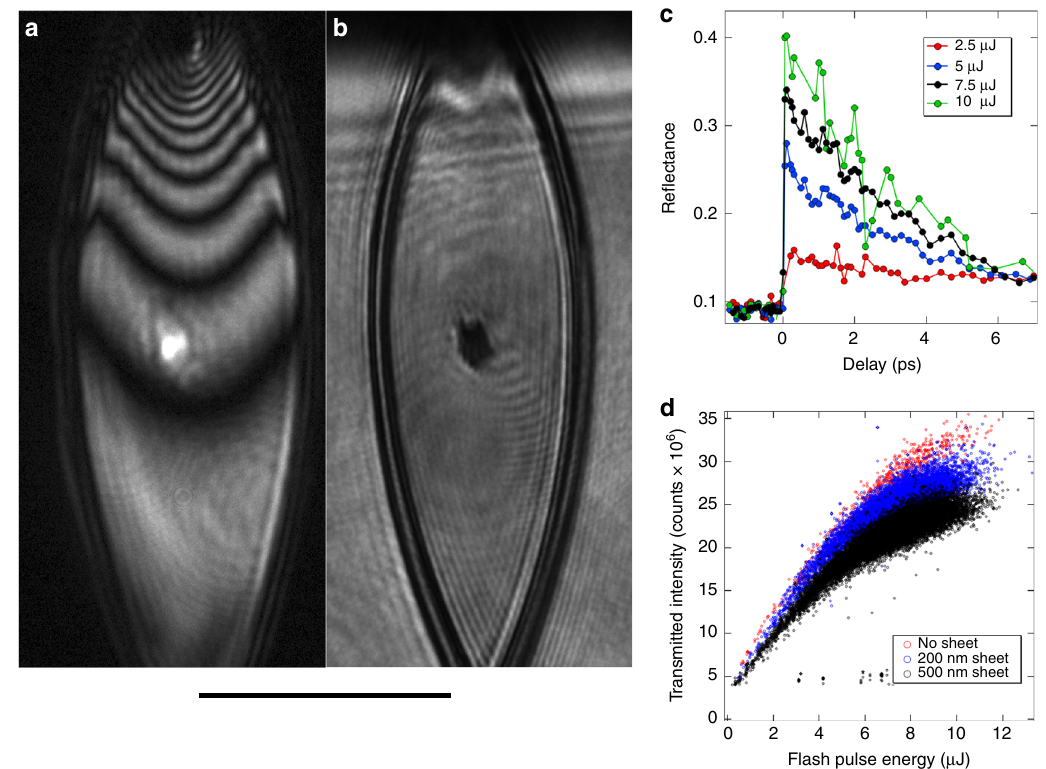
Fig. 6 Soft X-ray measurements of liquid water sheets. Measurements from the FLASH free-electron laser are shown as described in the text. Shown are optical re fl ection ( a ) and transmission ( b ) images taken in situ. The entire sheet was illuminated by an optical parametric ampli fi er (500 nm), which was used as a probe of the dynamics induced by the soft X-ray pulses. The X-ray spot can be seen as a bright spot in re fl ection and a dark spot in transmission, immediately following the X-ray pump. c The re fl ectivity of the X-ray pumped region of the water sheet, as a function of time delay between the X-ray pump and optical probe, for a series of different pump fl uences. d The intensity of soft X-rays transmitted through the water sheet, as a function of FLASH pulse energy, for different sheet thicknesses. The scale bar is 100 μ